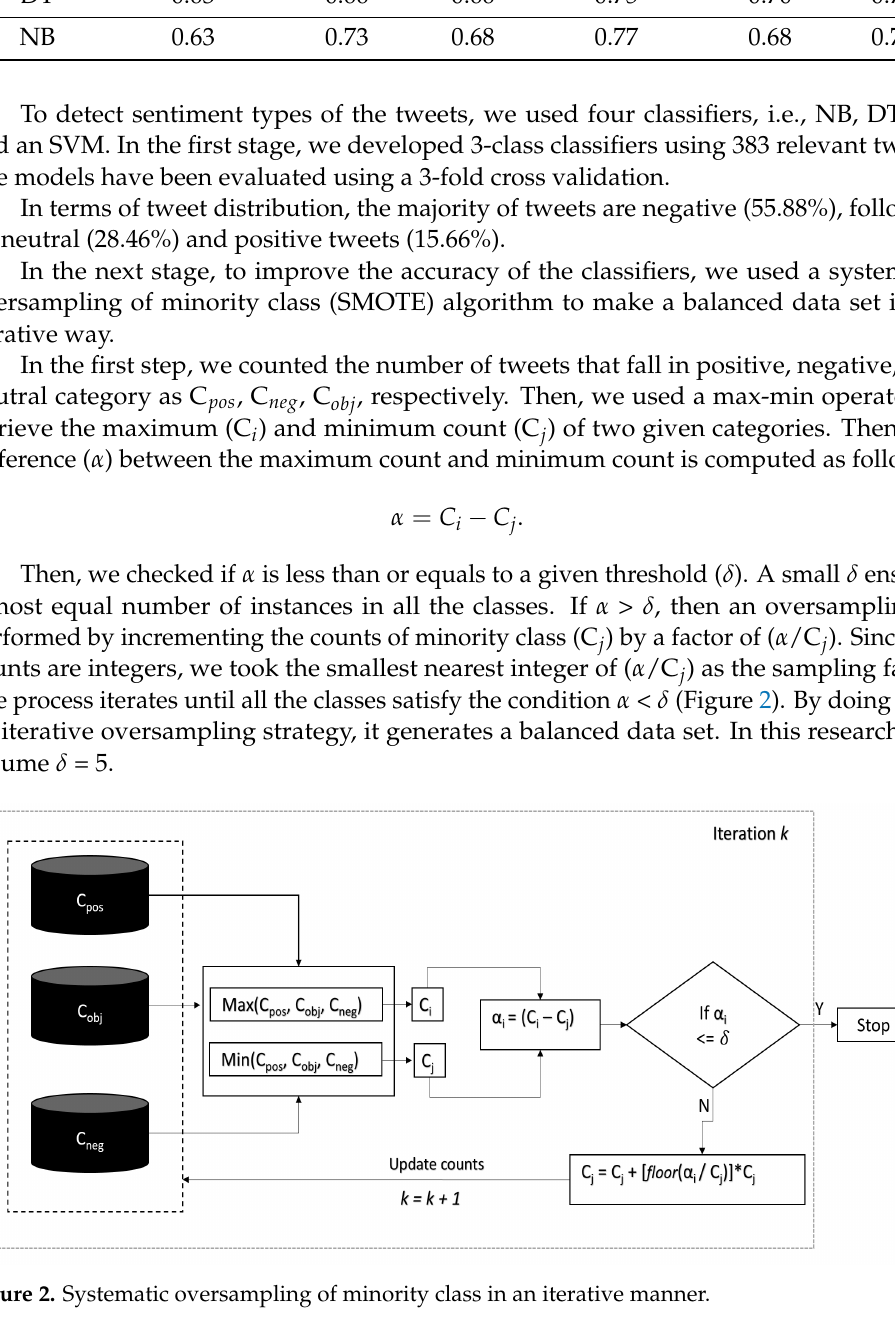
Figure 2. Systematic oversampling of minority class in an iterative